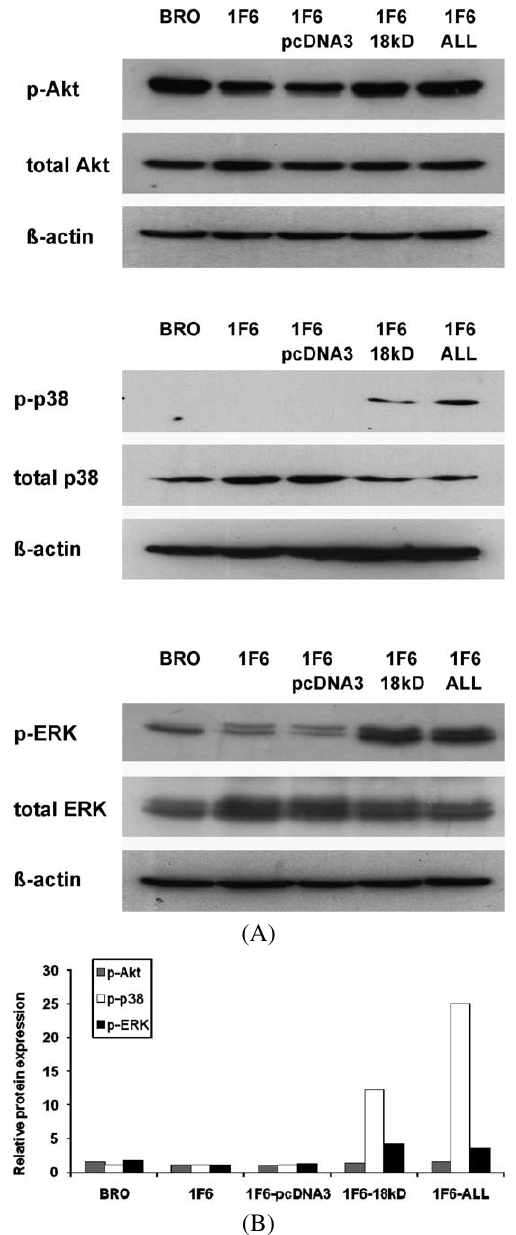
Fig. 5. Expression of Akt, p38 and ERK1/2 in BRO, 1F6 parent cells, 1F6-pcDNA3 and bFGF-overexpressing 1F6 clones. (A) Cell